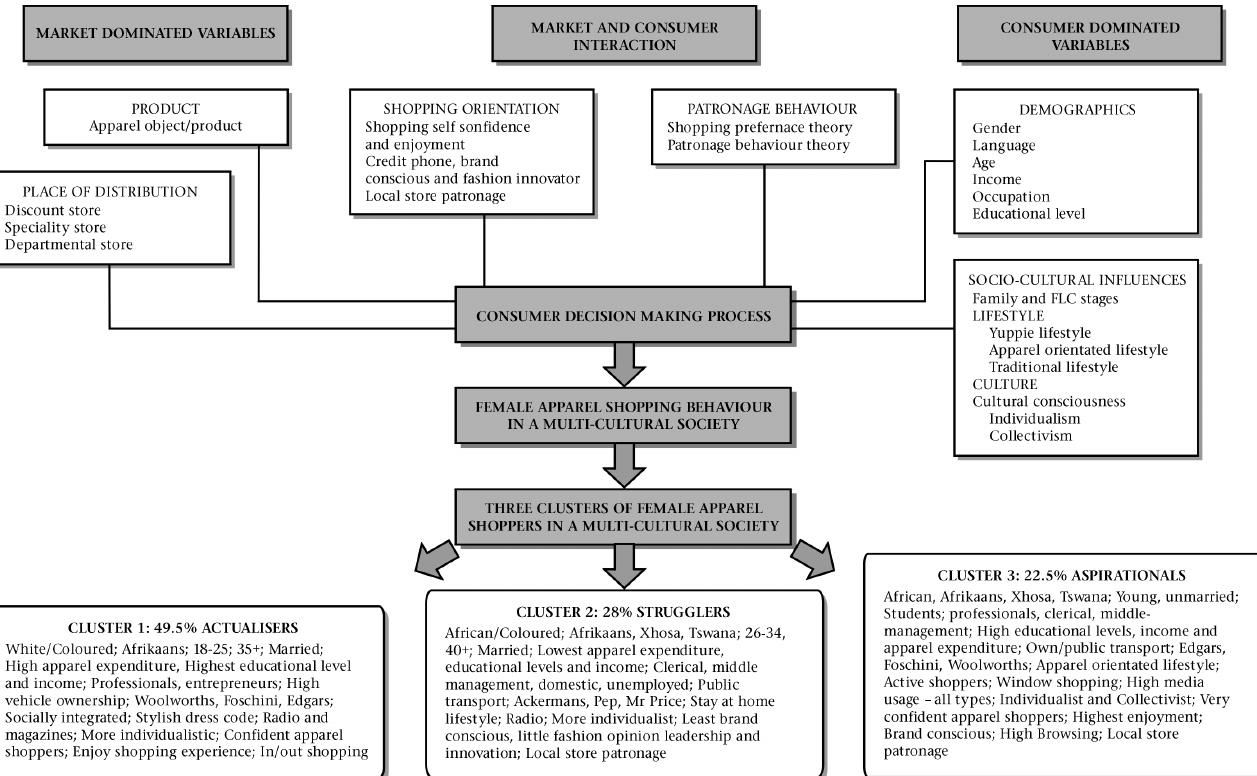
Figure 2: A theoretical model of selected variables influencing female apparel shopping behaviour in a multicultural consumer